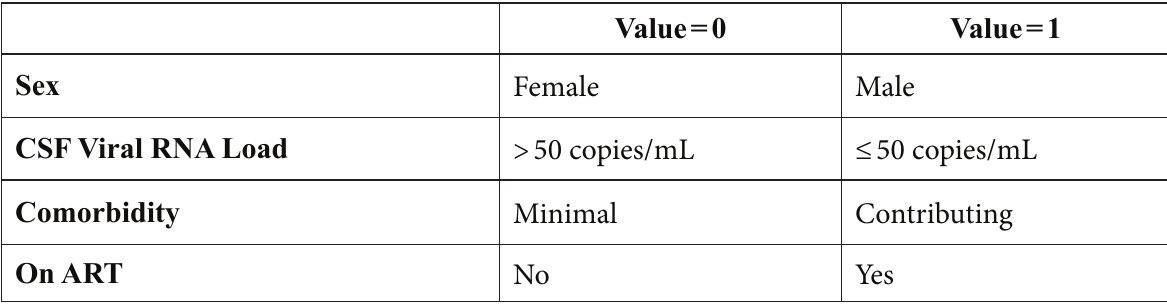
Supplementary Table 1. Coding of covariates for regressions